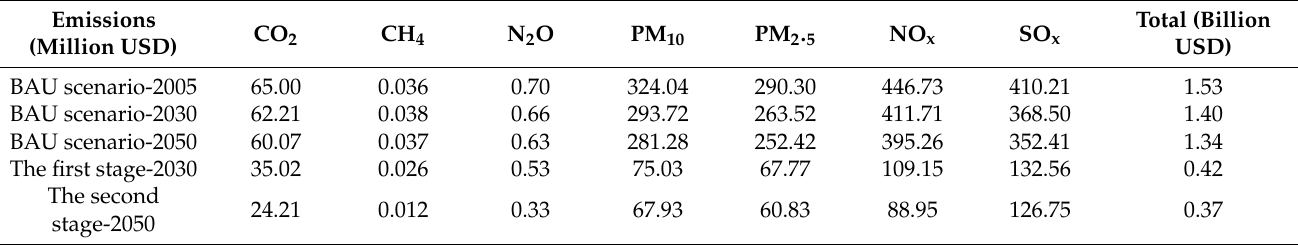
Table 3. External cost of emissions in the Port of Kaohsiung.